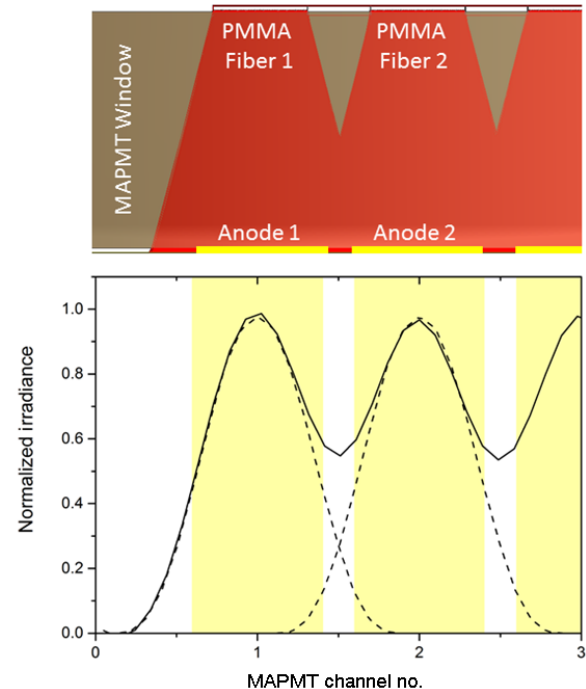
Figure 2. Results of optical modelling calculations for the light cou- pling between the PMMA fibre system and the multi-anode photo- multiplier. A crosstalk of at least 15% can be expected that needs to be taken into account in the analysis of the polar nephelometer